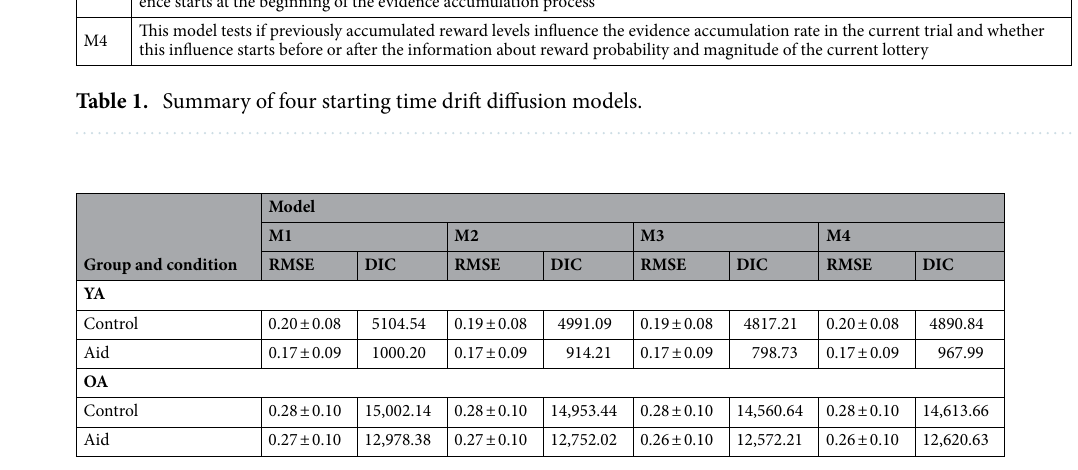
Table 2. Root-mean-squared-error and deviance information criterion value of each model for the model comparison. This table reports the mean and standard deviation of RMSE and the DIC value calculated by the hierarchical Bayesian Markov Chain Monte Carlo method for each age group and each condition. Abbreviations: YA = younger adults; OA = older adults; Aid = decision-aid; RMSE = root-mean-squared-error; DIC = deviance information